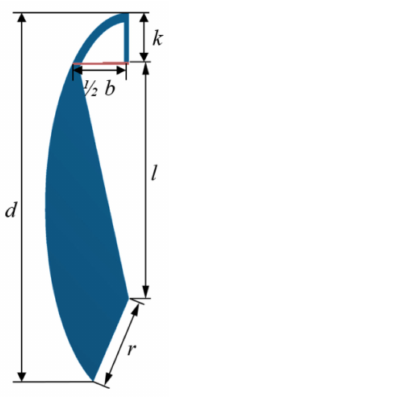
Figure 5. Models analyzed numerically: the scheme